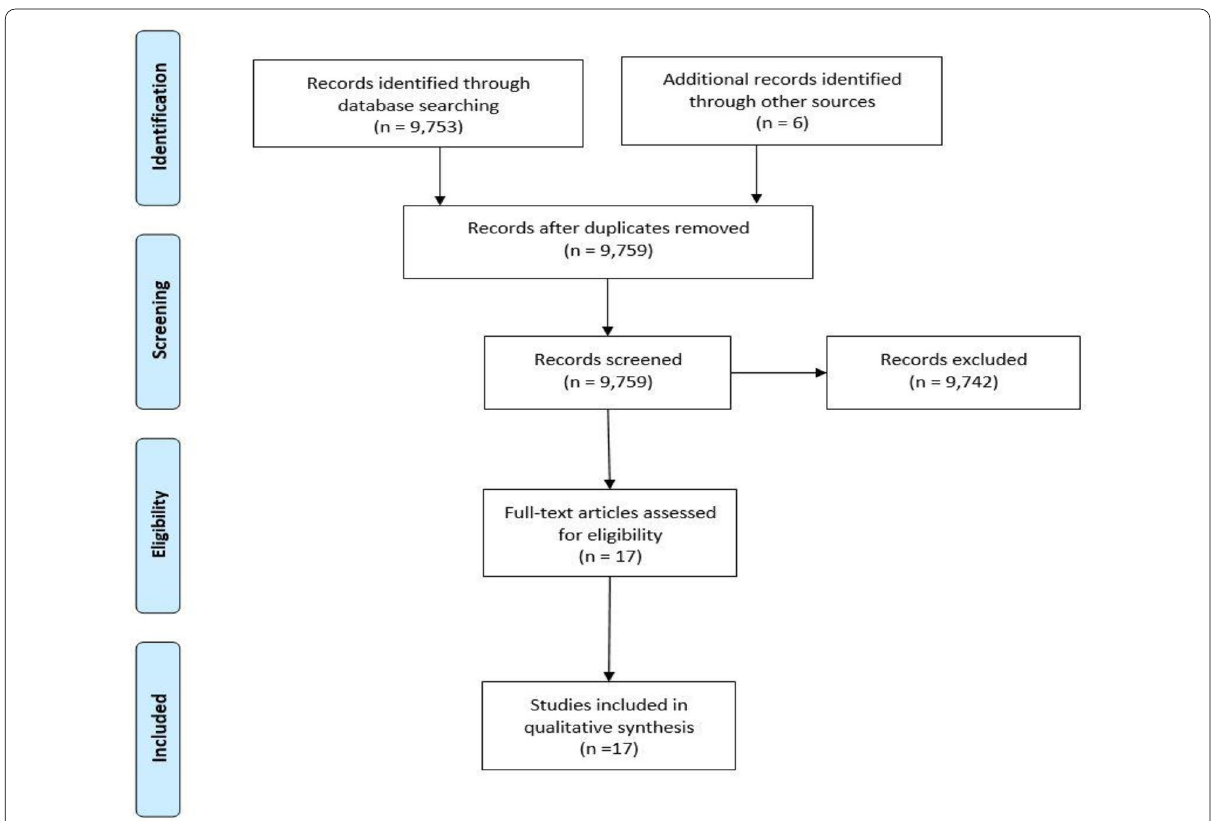
Fig. 1 PRISMA diagram showing scoping review employed by